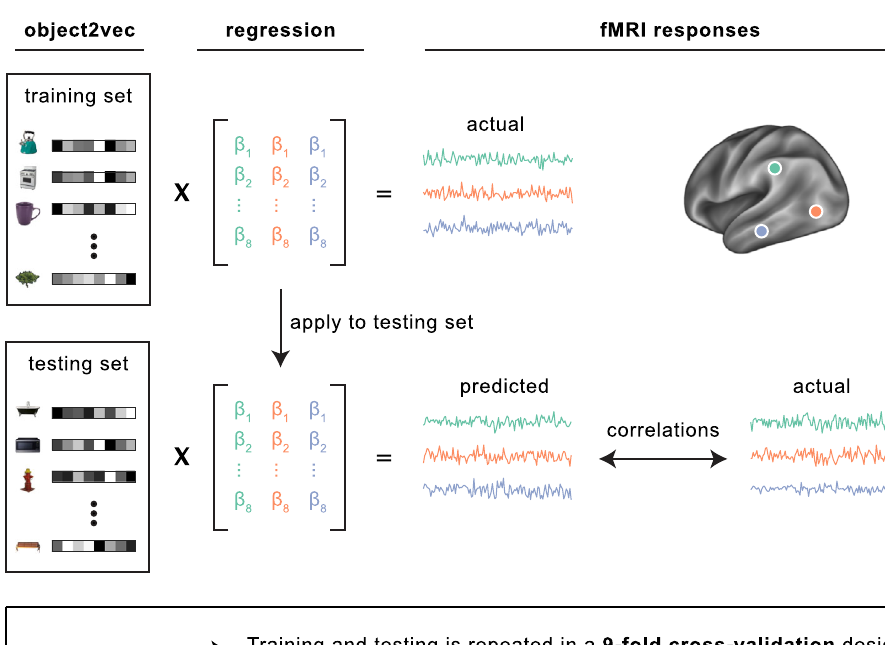
Fig. 3 Encoding model of visual object context. Voxel-wise encoding models were used to assess whether our statistical model of visual object context (object2vec) could reliably explain variance in the fMRI responses to the experimental object categories. Linear regression was used to map the representations of object2vec onto fMRI responses. We assessed the out-of-sample prediction accuracy of these regression models through a 9-fold cross-validation procedure. Each fold of the cross-validation design contains a set of object categories that do not appear in any other fold. These folds were shown in separate fMRI runs. Parameters for the voxel-wise linear regression models were estimated using the fMRI data for 8 folds of the object categories and the learned regression weights were then applied to the held-out object categories in the remaining fold to generate a set of predicted fMRI responses. This procedure was repeated for each fold of the cross-validation design, and the predicted fMRI responses from each fold were concatenated together. Prediction accuracy was assessed by calculating the voxel-wise correlations of the predicted and actual fMRI responses across all object categories.